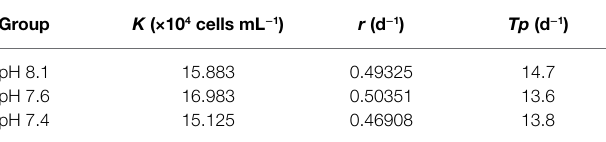
TABLE 2 | Regressions of the logistic model on K. mikimotoi population growth when exposed to seawater acidification conditions.